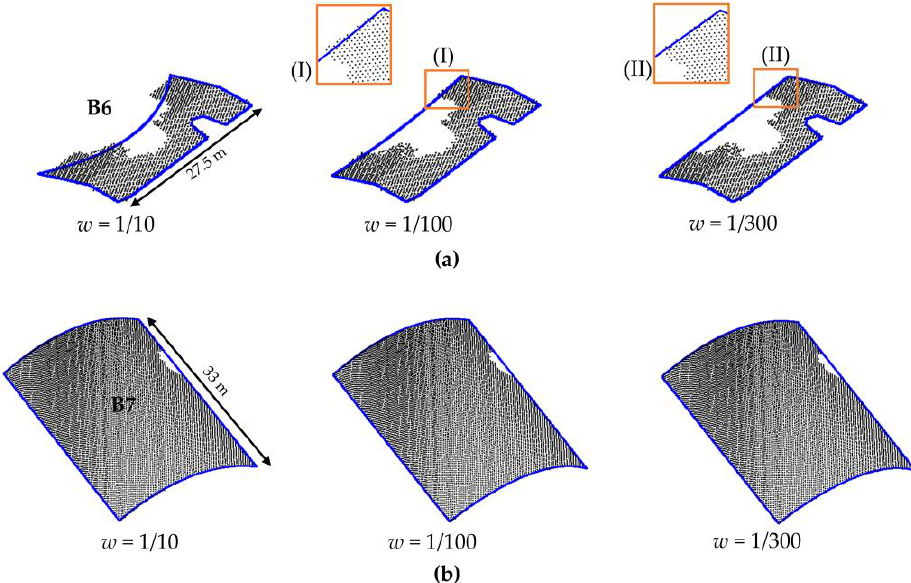
Figure 11. Modeled contour for buildings B6 ( a ) and B7 ( b ) using different weight values.